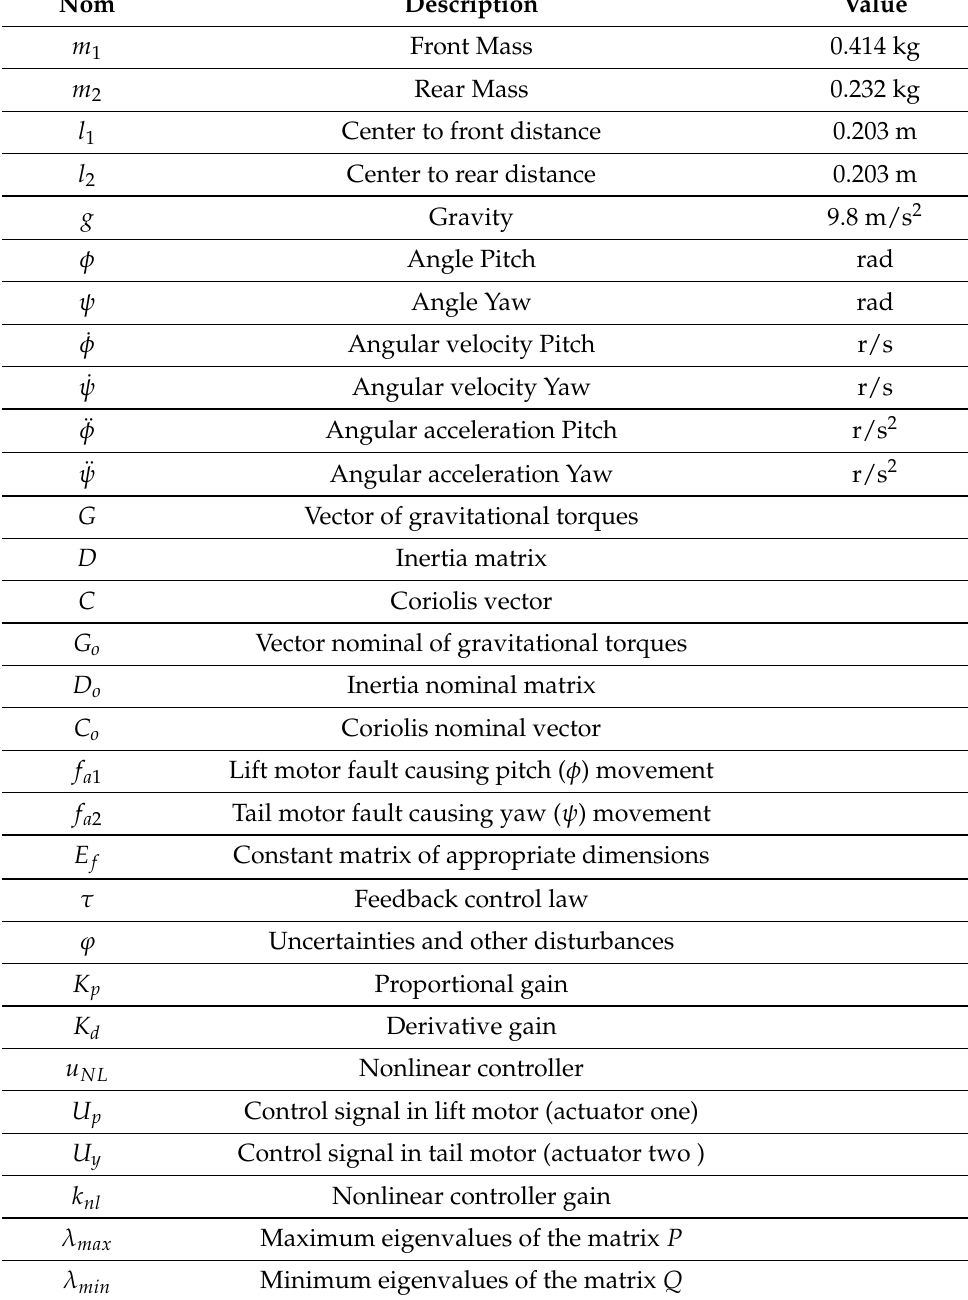
Table A1. Parameters and symbols used in the simulation and experimentation